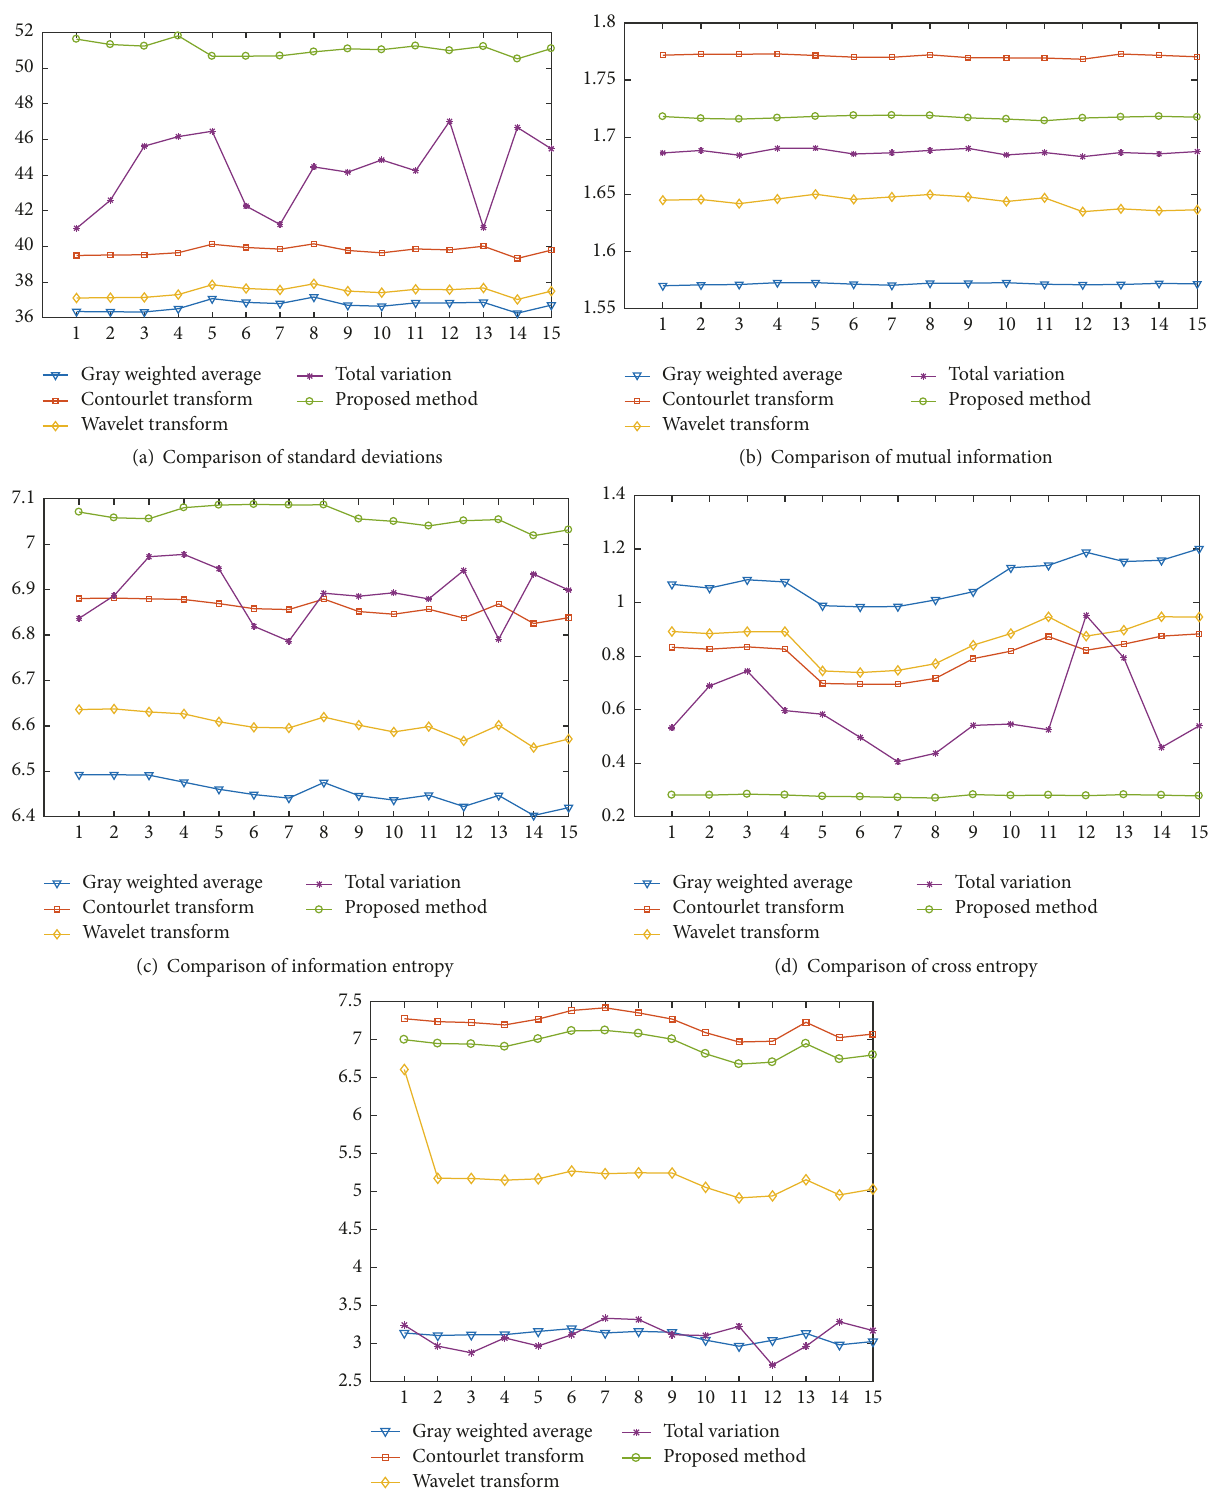
Figure 12: Quantitative evaluation of day images